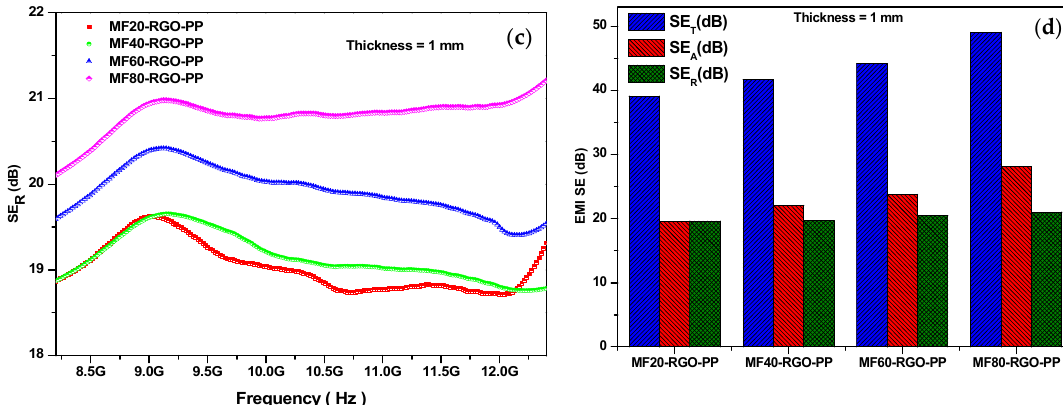
Figure 12. EMI shielding effectiveness ( a ) SE T , ( b ) SE A , ( c ) SE R and ( d ) comparison plot of SE T , SE A and SE R for MF20-RGO-PP, MF40-RGO-PP, MF60-RGO-PP and MF80-RGO-PP nanocomposite sheet at thickness of 1 mm.